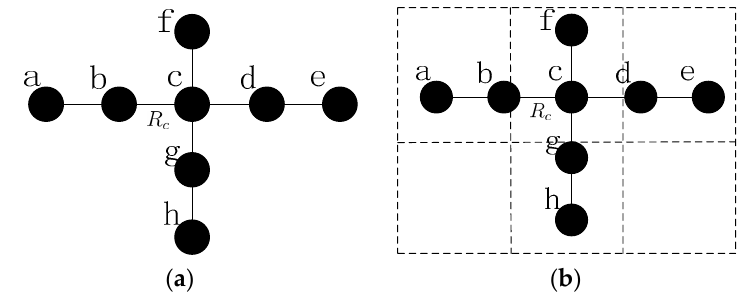
Figure 7. ( a ) Special case; and ( b ) special case after gridding.